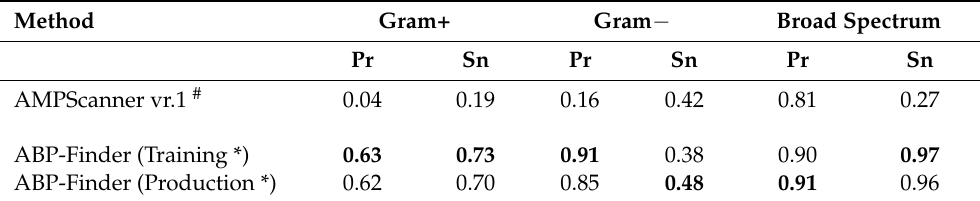
Table 5. Comparison of ABP-Finder with AMP-Scanner_v1 in the discrimination between Gram-staining classes within the validation set. The values in bold denote the best performance for a given measure.